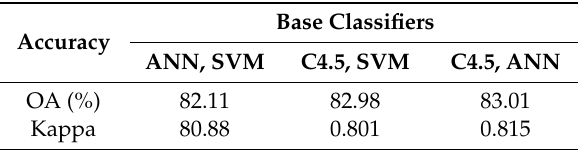
Table 7. MCS_WV classification accuracy with two base classifiers.